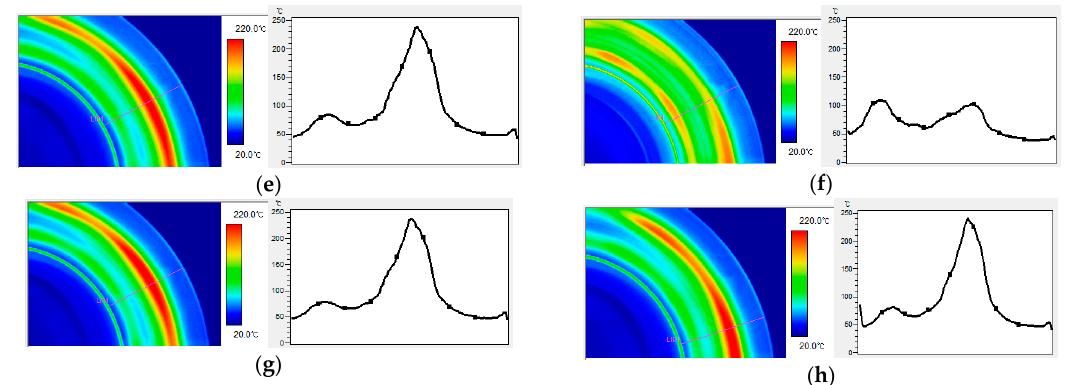
Figure 4. Infrared images of stop braking and a temperature profile along a radial line. ( a ) 4.805 s after brake application, ( b ) 6.940 s, ( c ) 7.341 s, ( d ) 8.809 s, ( e ) 33.634 s, ( f ) 34.835 s, ( g ) 35.502 s, ( h ) 36.303 s.